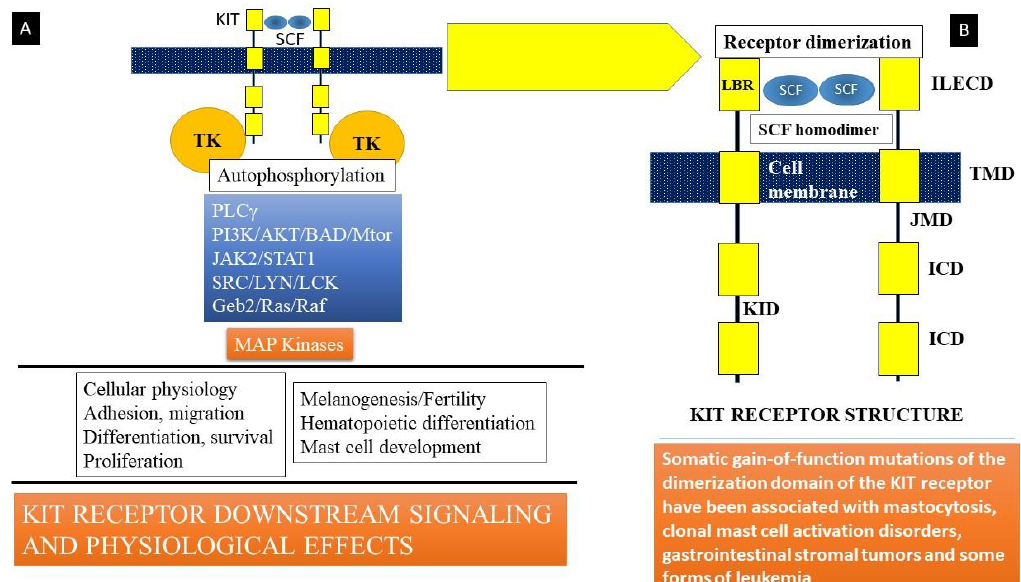
Figure 2. ( A ) Stem cell factor (SCF) is a hematopoietic growth factor that binds to its receptor, KIT, a transmembrane tyrosine kinase-linked receptor on mast cells. Signaling downstream involves activation of key kinases (Phospholipase C γ (PLC γ ), protein kinase C (PKC), and linked signaling proteins: Janus kinase 2 (a non-receptor tyrosine kinase, JAK2), signal transducer and activator of transcription 1 (STAT1), and other signal transduction mediators). These lead to action of mitogen-activated protein kinases (MAP kinase). Somatic mutations in c-KIT that code for the KIT receptor have been linked to the development of systemic mastocytosis, a clonal hematological disorder. The most common of these mutations is the D816V mutation that leads to enhanced survival and proliferation of mast cells, a feature of clonal mast cell disorders including mastocytosis and mast cell activation disorders. ( B ) KIT is the cellular counterpart of the v-KIT oncogene derived from a feline leukemia virus. It is encoded in the W or c-KIT locus on human chromosome 4q11-q12. KIT is composed of an immunoglobulin-like extracellular domain (ILECD), that is involved in ligand binding (LBR), an anchoring transmembrane domain (TMD), a juxta-membranous domain (JMD), and intracellular domains (ICD). KID = kinase insert domain. Binding of stem cell factor to KIT results in receptor dimerization and activation of protein kinase activity.